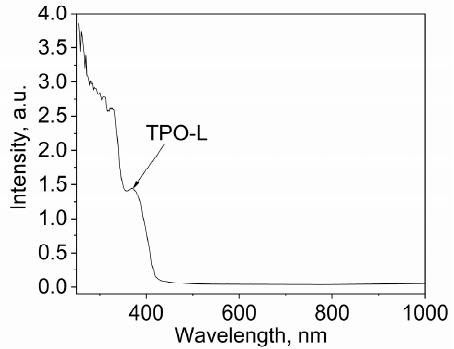
Figure 6. UV light absorption spectra of OSTE-MS polymer.